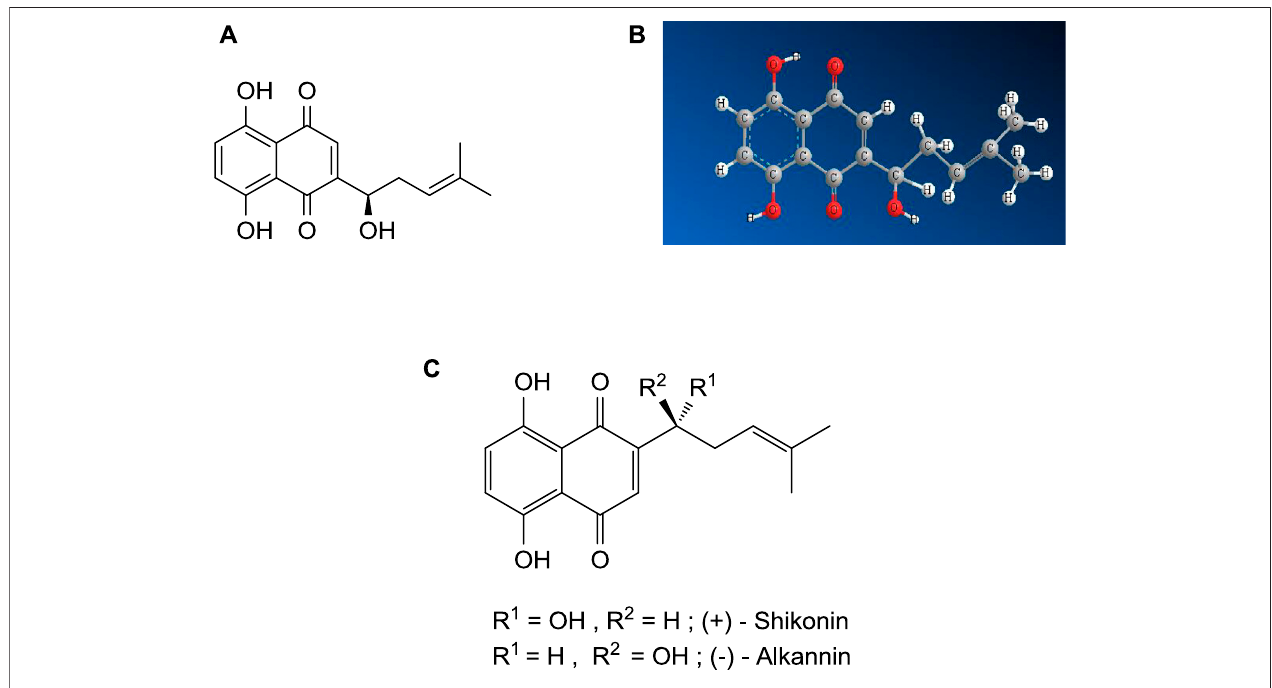
FIGURE 1 | (A) Shikonin - 2 D structure, (B) Shikonin — 3 D structure, (C) Shikalkin (a racemic mixture of alkannin and shikonin).